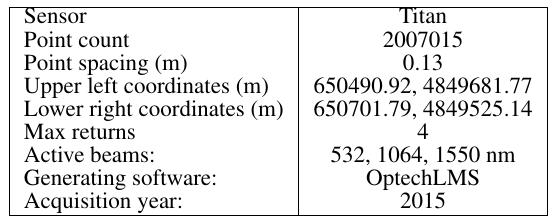
b- LiDAR point cloud - height values Figure 3. Datasets